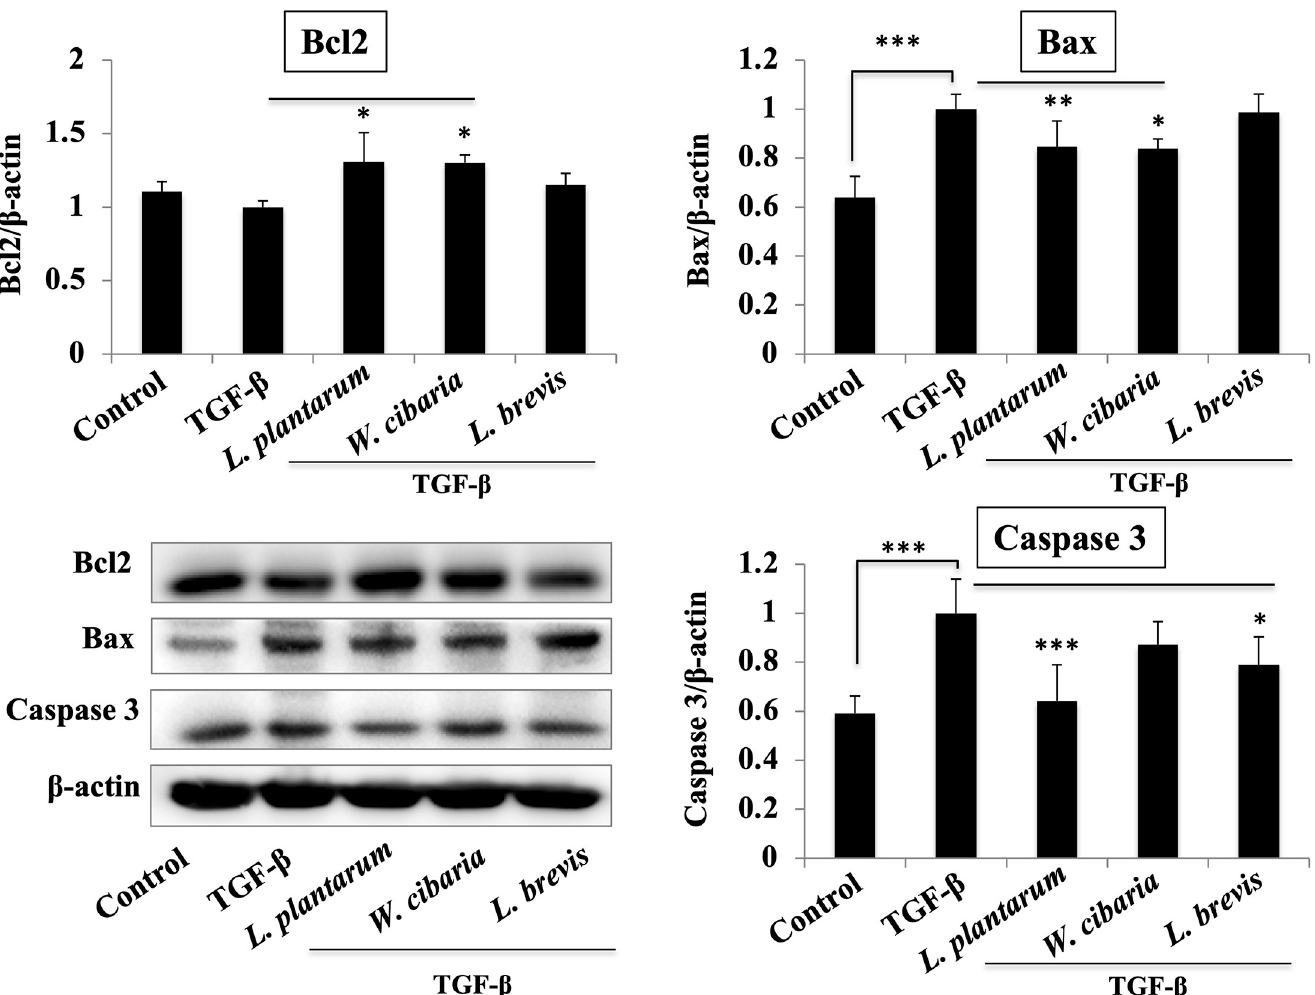
Fig 8. LAB strains modulate the apoptosis-associated markers in LX-2 in response to TGF- β . Confluence LX-2 cells were treated with LABs for 48 h, then stimulated with TGF- β for 120 minutes. Western blot was performed to determine the level of Bcl-2, Bax, and Caspase 3 at the indicated time point. The Image J software was used to determine the intensities of protein bands. The bar graphs are the average of two different experiments (mean + S.D). � p < 0.05, �� p < 0.01, ��� p < 0.001.